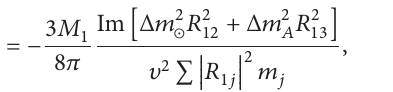
versus 𝜒 2 sensitivity corresponding to CP discovery potential at LBNEs, for both the hierarchies and octant